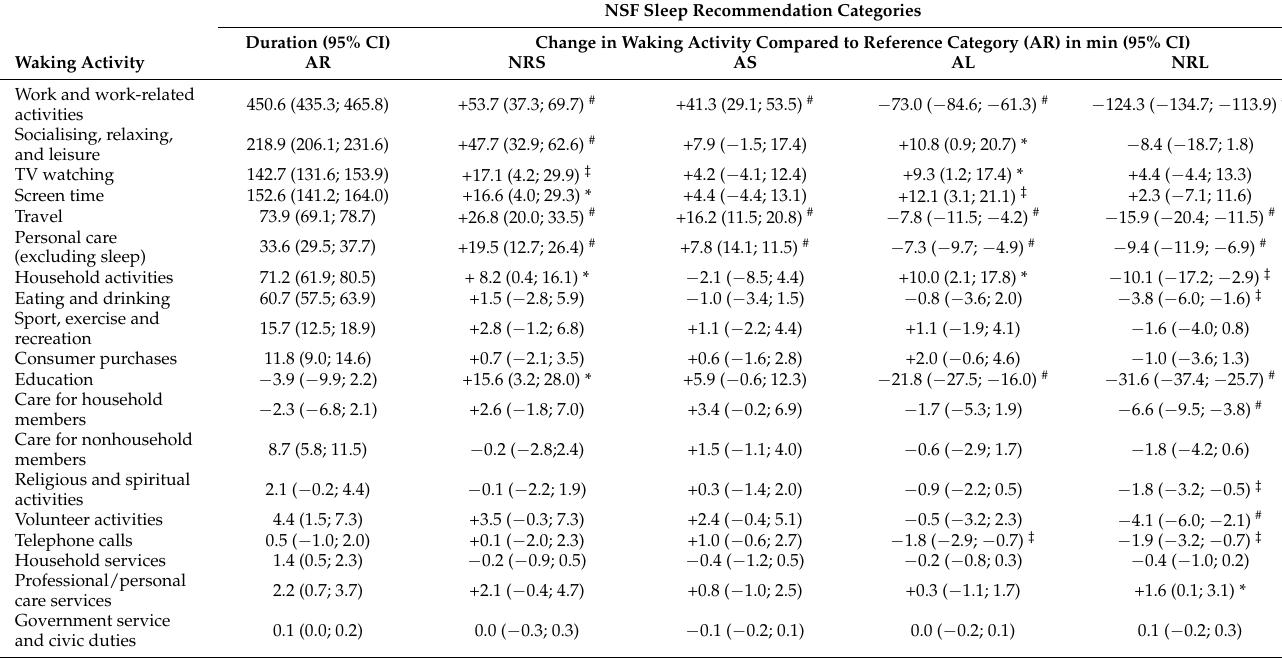
Table 7. Relationship between daily time spent on each of the waking activities (in minutes) and adherence to NSF sleep duration recommendation on weekdays ( N = 15,631).